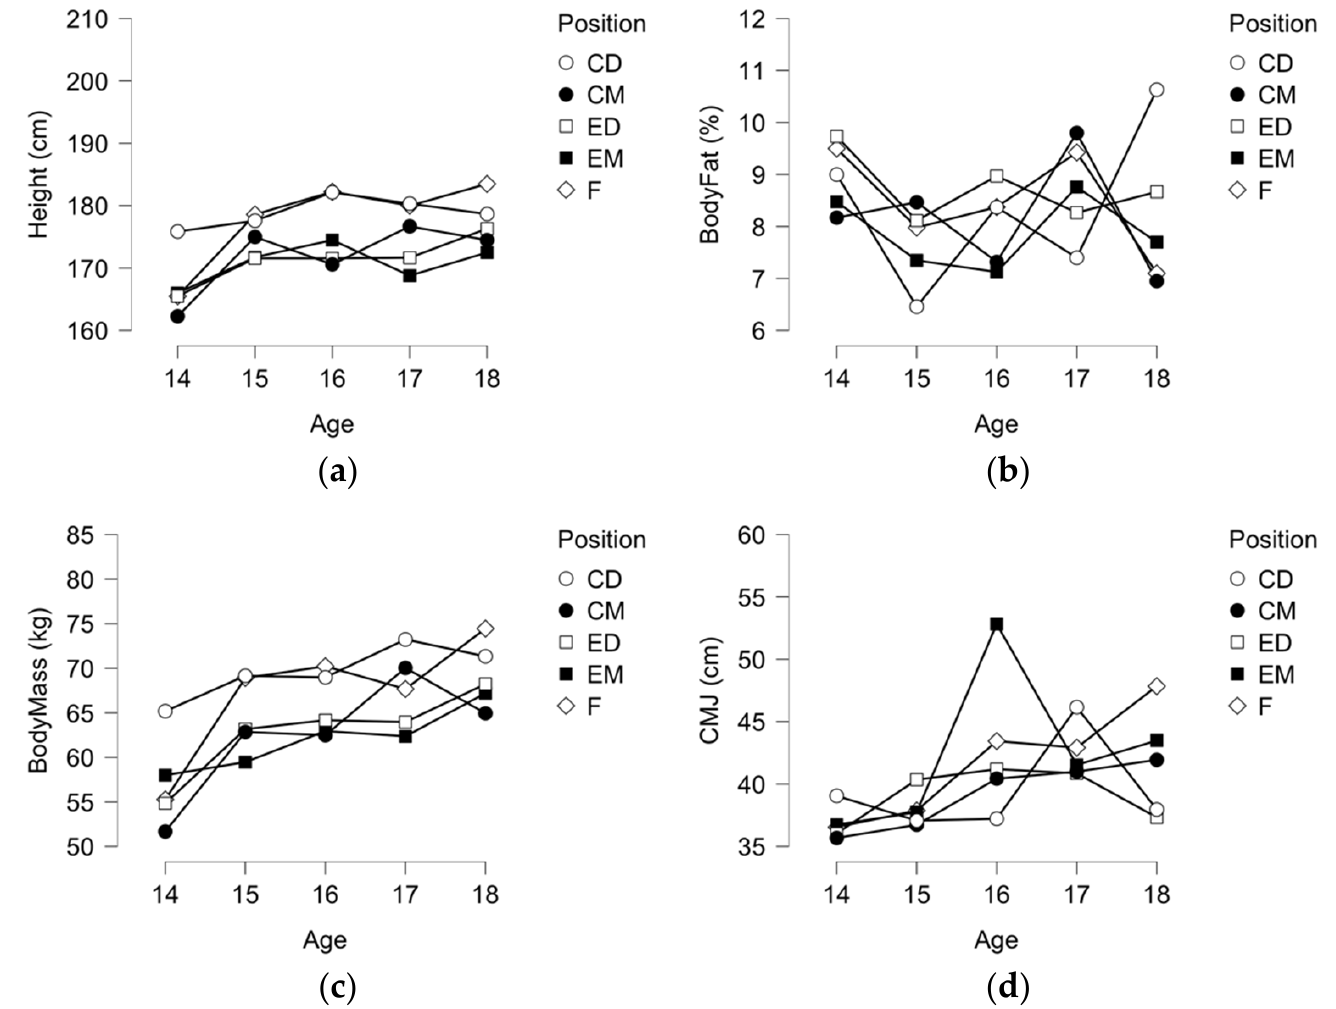
Figure 1. Descriptive plots for (a) height (cm); ( b ) body fat (%), ( c ) body mass (kg); and ( d ) CMJ (cm).